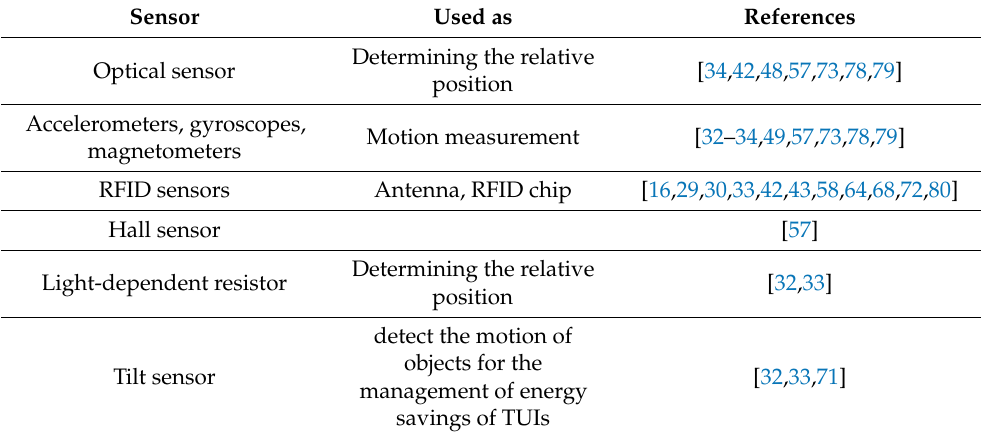
Table 4. Used sensors in technical solutions of